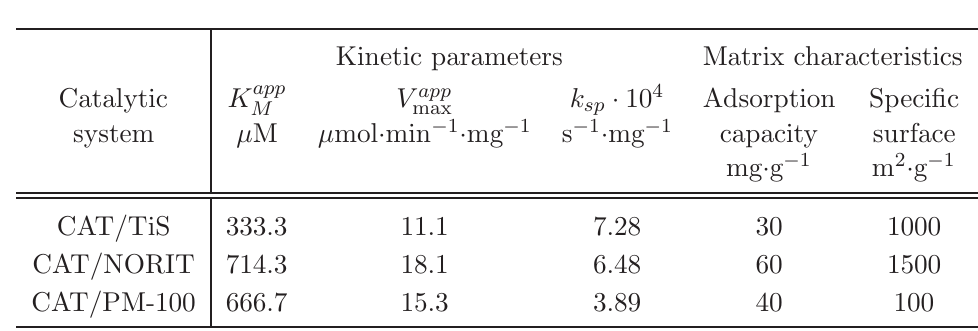
Table 1 The kinetic parameters of 3-chlorperoxibenzoic acid cleavage in acetonitrile by catalase, immobilized on different matrices; the adsorption capacity and specific surface of the